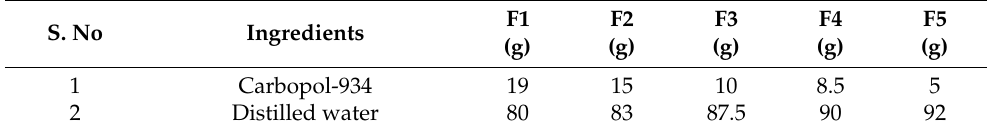
Table 3. Composition of hydrogel ( w / w